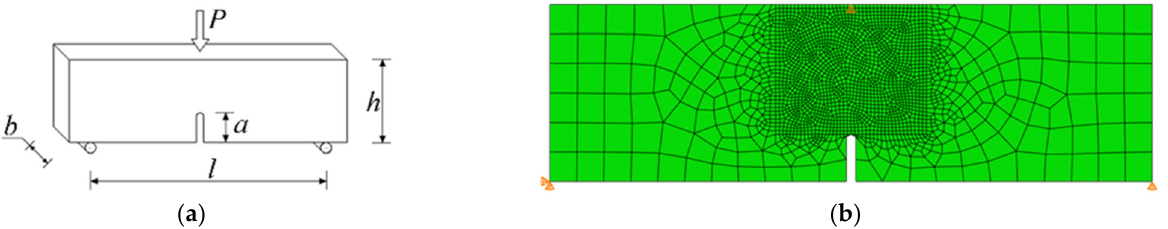
Figure 11. Test of three-point bending of a beam with a notch: ( a ) task scheme; ( b ) computer model mesh.